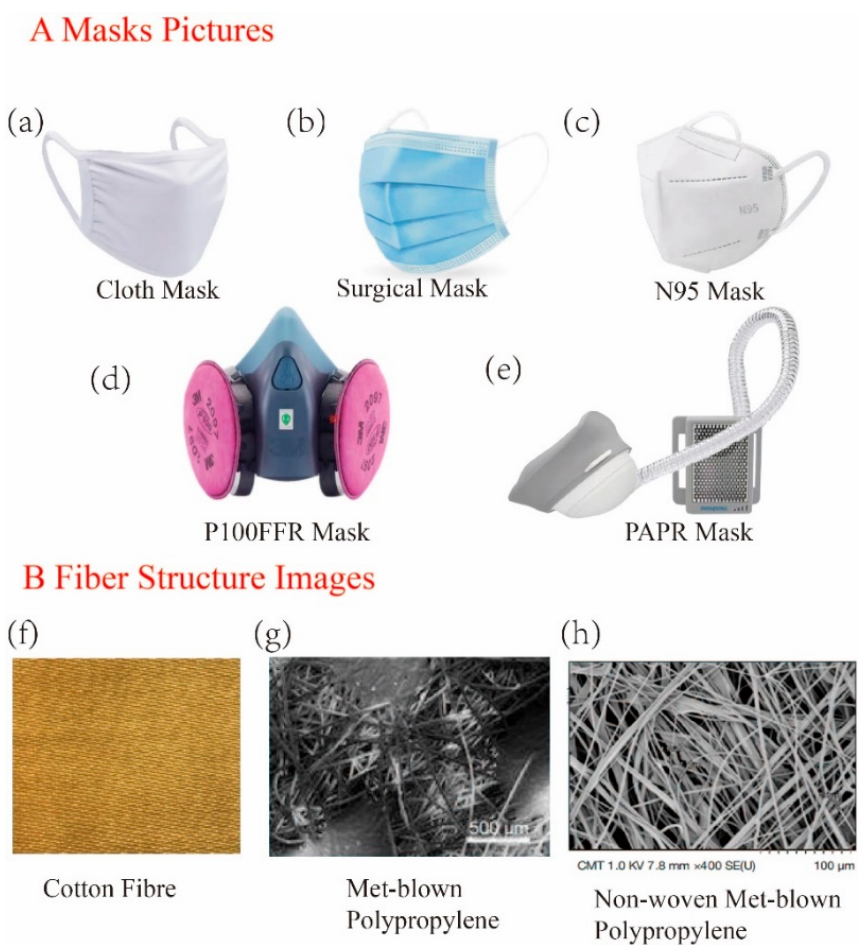
Figure 1. Mask pictures and fiber structure images [17,37,38]: ( A ) represents the mask pictures, including cloth masks, surgical masks, N95 masks, P100FFR masks, and PAPR masks; ( B ) shows the fiber structure images and cotton fiber, melt-blown polypropylene, and non-woven melt-blown polypropylene materials that are used in masks.